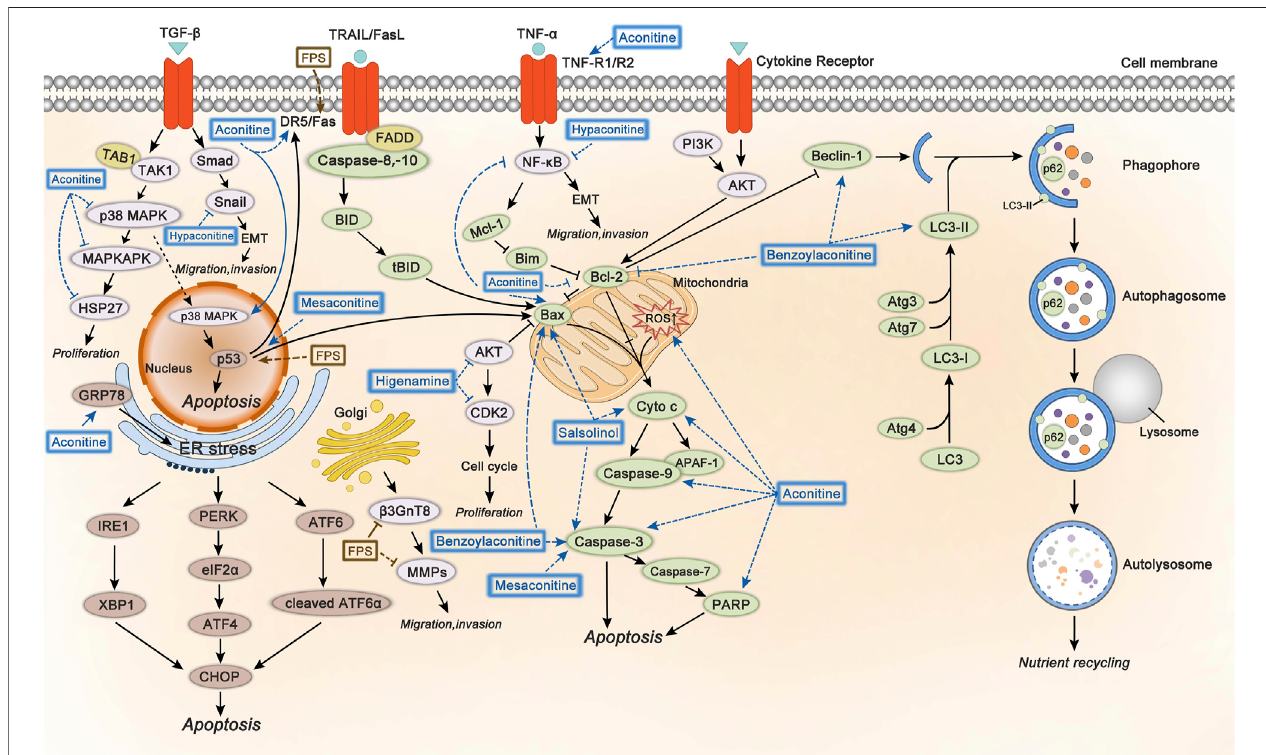
FIGURE 5 | The molecular mechanisms of Fuzi against cancer. 1) Fuzi induced cell autophagy and conducted apoptosis by targeting mitochondrial-mediated pathway anddeathreceptor-mediated pathway.2)Fuziinhibitedcellproliferation,migration,andinvasionviaregulatingp38MAPK,AKT,EMT, β 3GnT8andMMPs.The blue and brown solid arrows indicated direct targets of Fuzi alkaloids and FPS respectively. Correspondingly, the blue and brown dotted ones indicated downstream effects induced by Fuzi alkaloids and FPS.